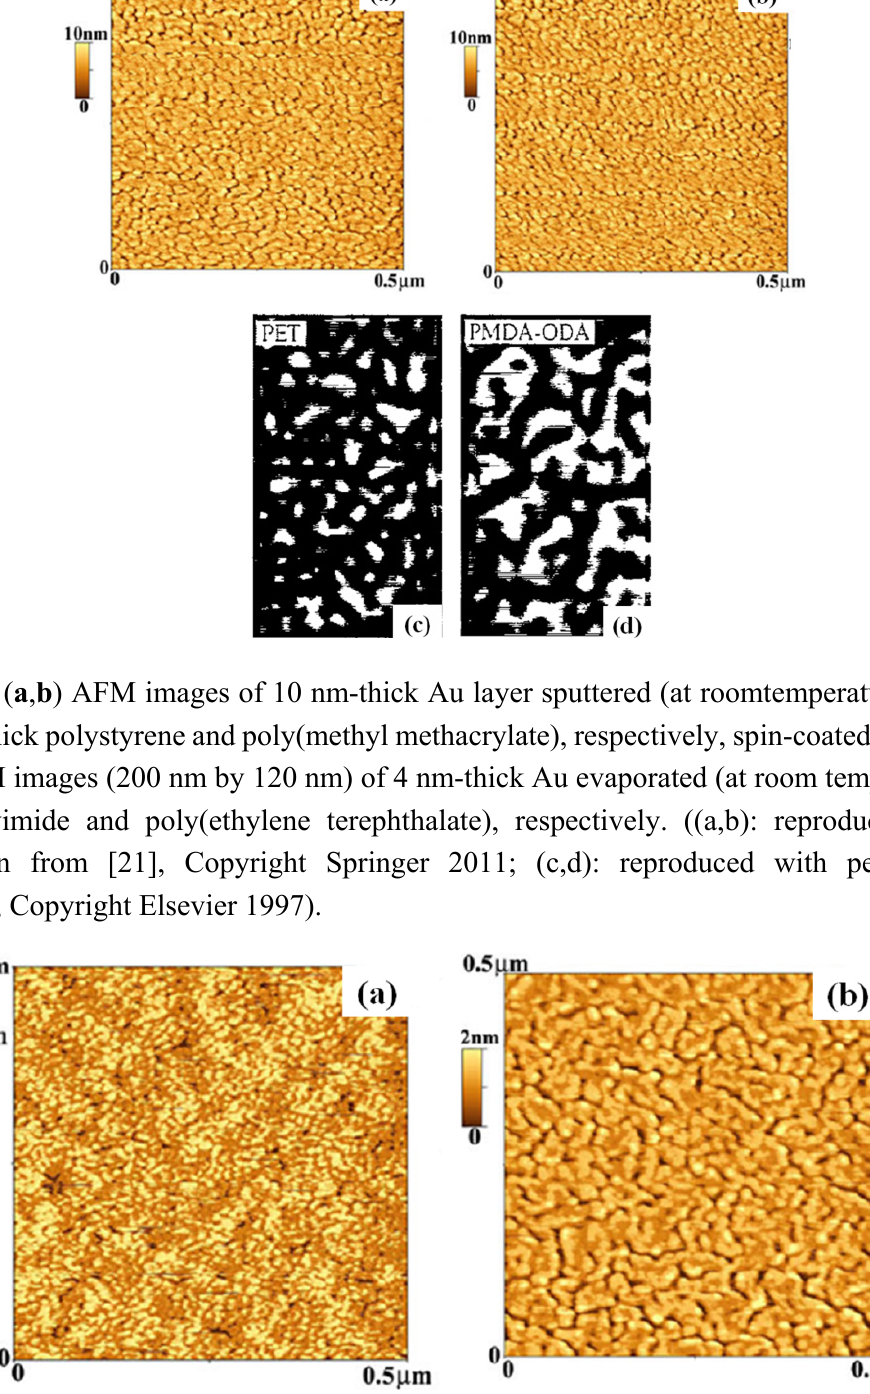
Figure 3. ( a , b ) AFM images of 20 nm-thick Au layer sputtered (at room temperature) onto 200 nm-thick polystyrene and poly(methyl methacrylate), respectively, spin-coated on Si. (Reproduced with permission from [21], Copyright Springer